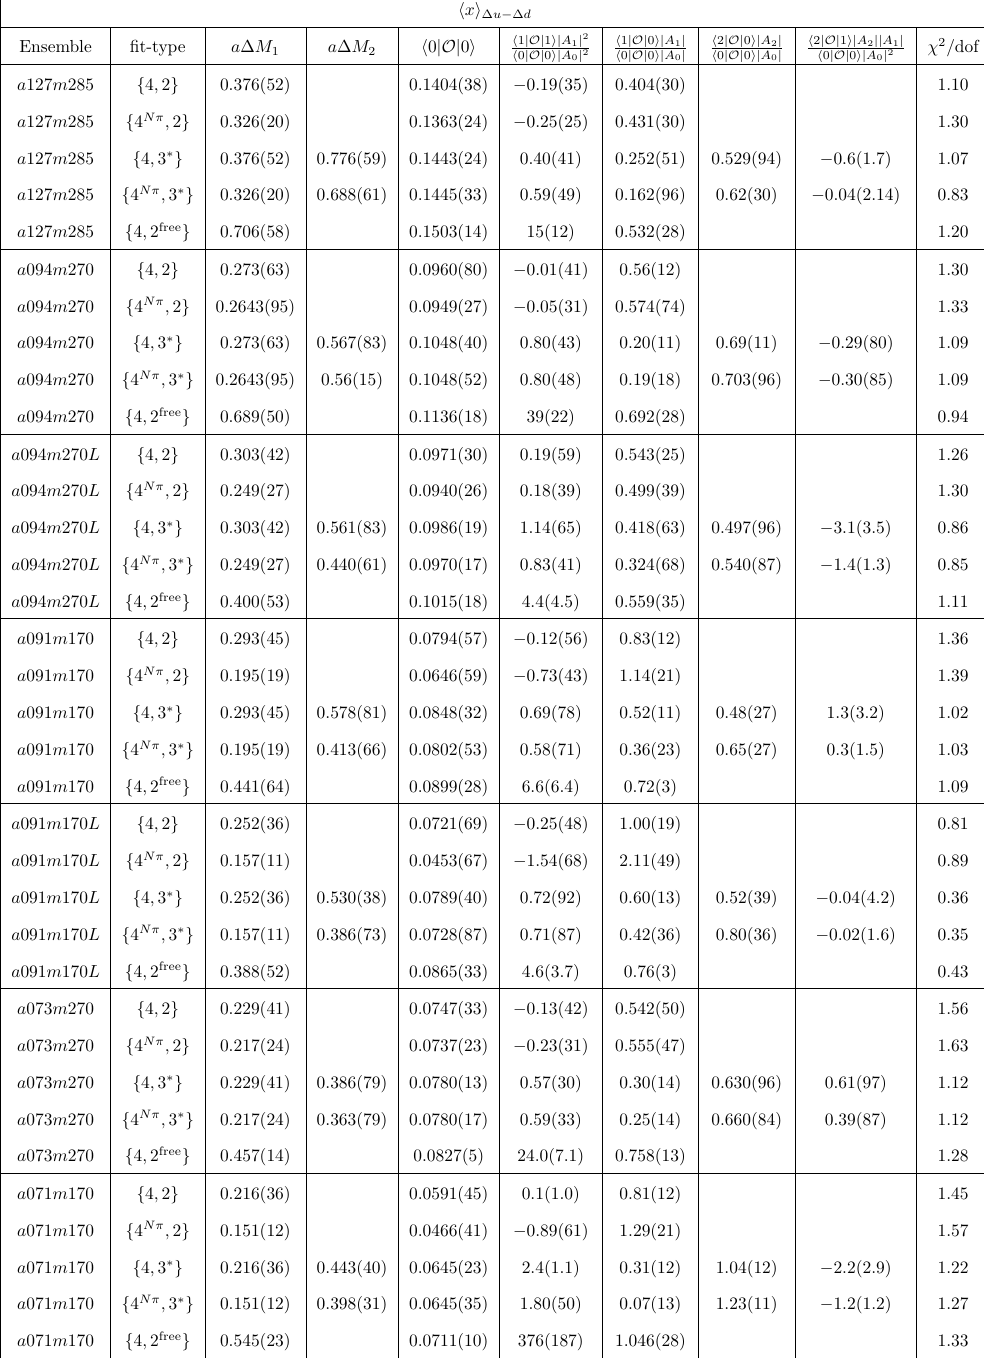
Table 8 . Comparison of results of the fits to remove the excited-state contamination for the helicity moment h x i . The rest is the same as in table ∆ u − ∆ d